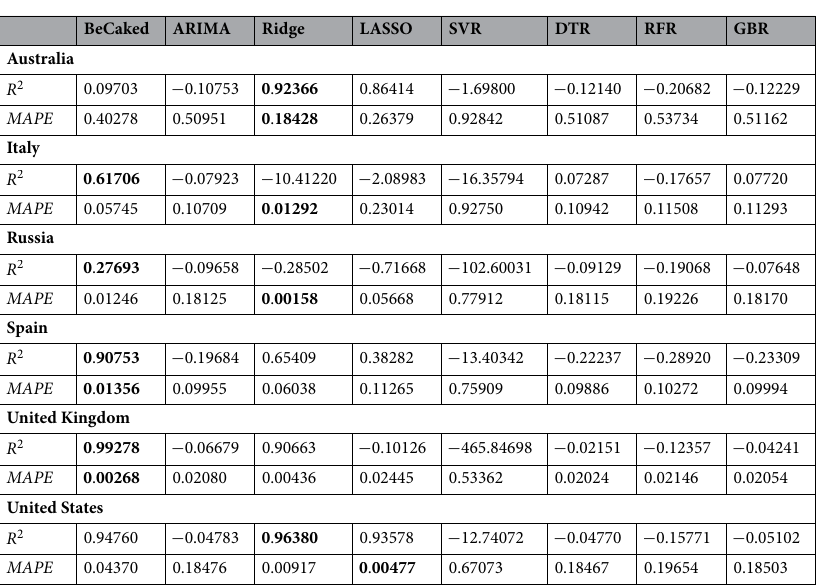
Table 6. Comparison of BeCaked and top-tier forecasting-specialized methods at country level with 15-step forecast. Best results are in [bold].